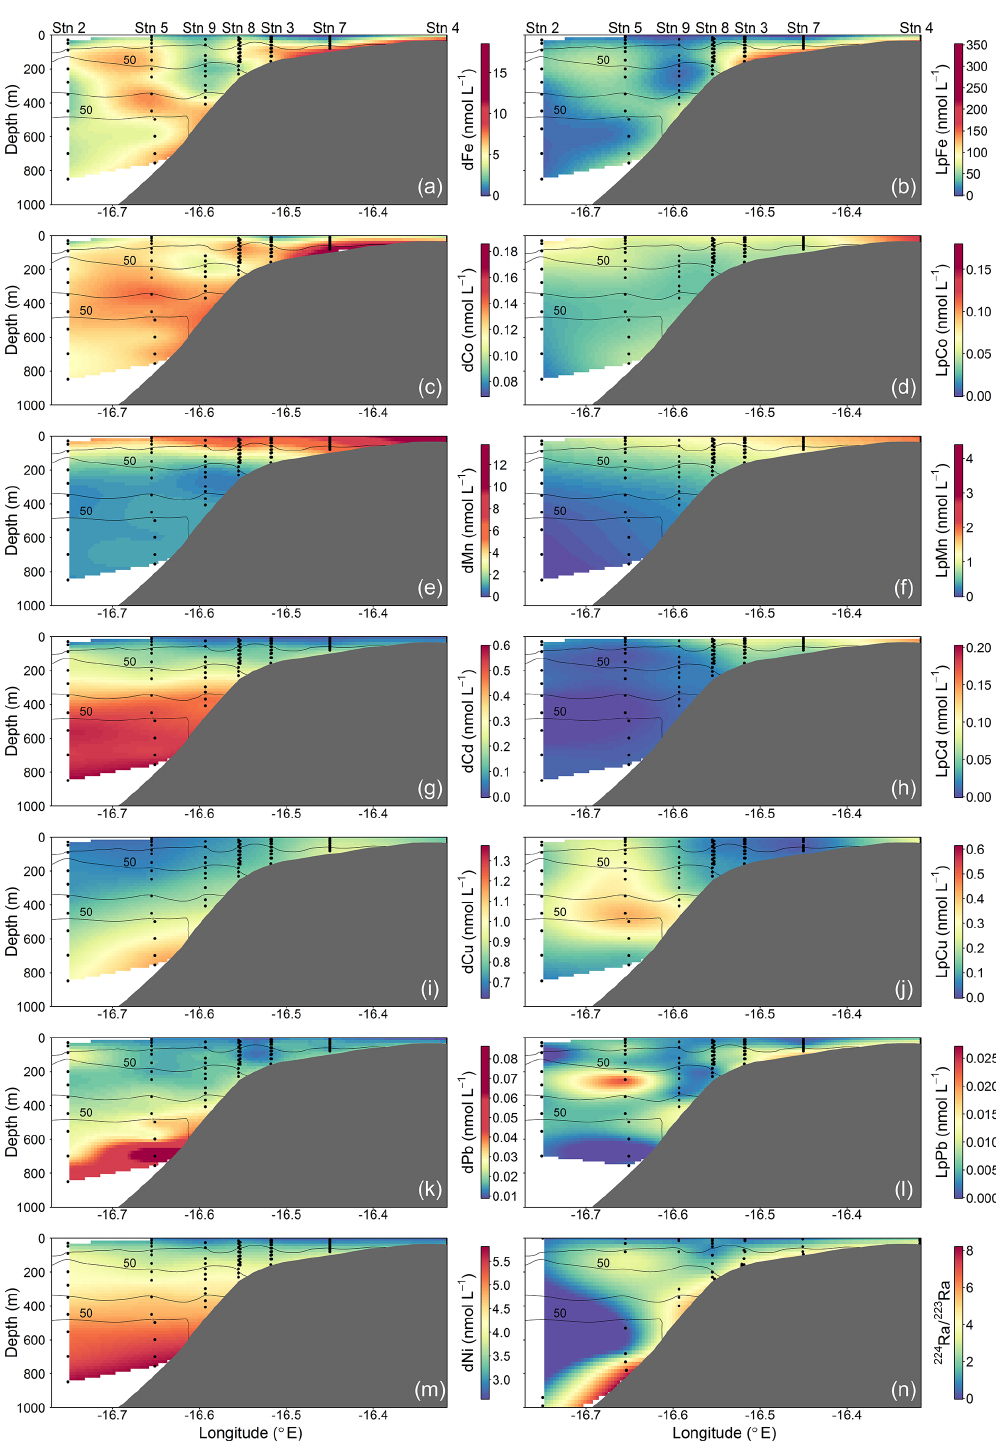
Figure 3. Spatial distributions of dissolved (d) and leachable particulate (Lp) trace metals and 224 Ra / 223 Ra across the Mauritanian shelf at 18 ◦ 20 (cid:48) N in June 2014. Each sample location is indicated by a black dot and oxygen contours at 50µmolkg − 1 enclosing the upper and lower OMZ are displayed with black contour